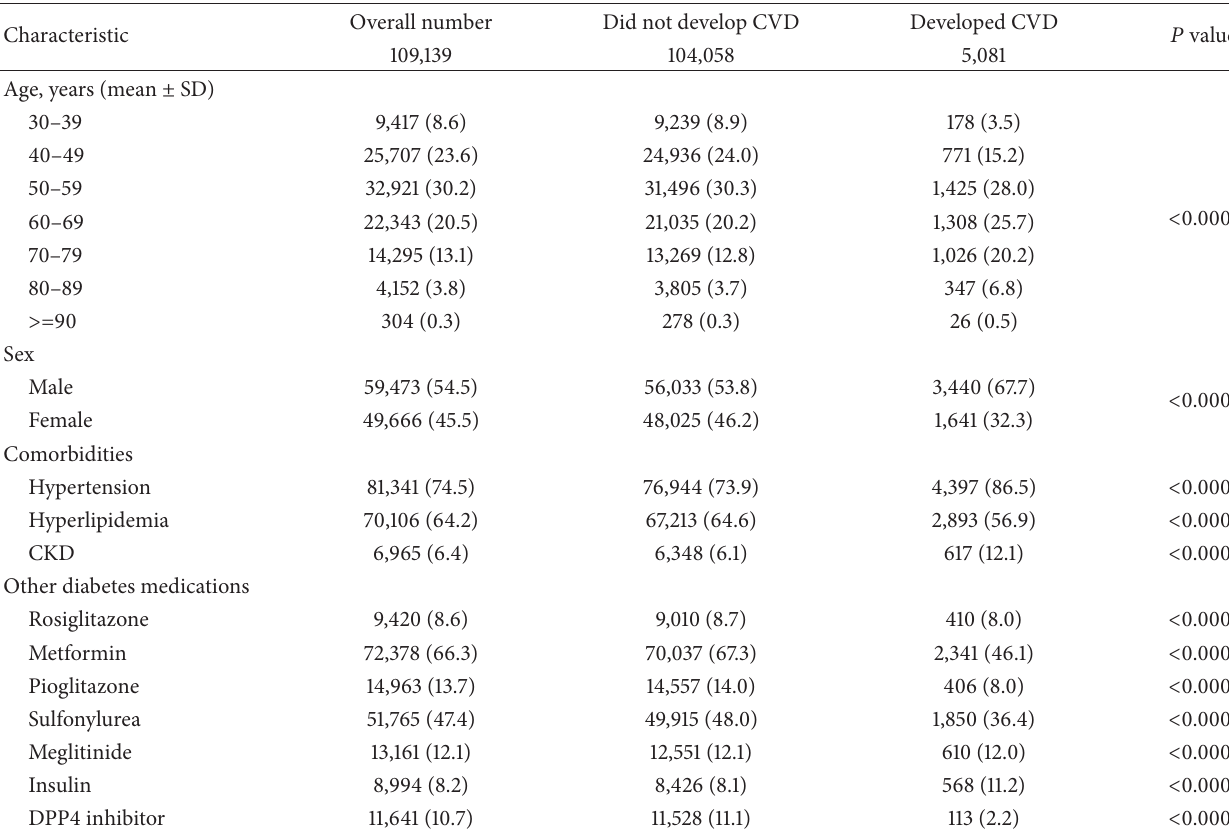
Table 1: Demographics, comorbidities, and concomitant use of antidiabetic medications in those acarbose users with ( 𝑛 = 5081 ) or without (104058) CVD